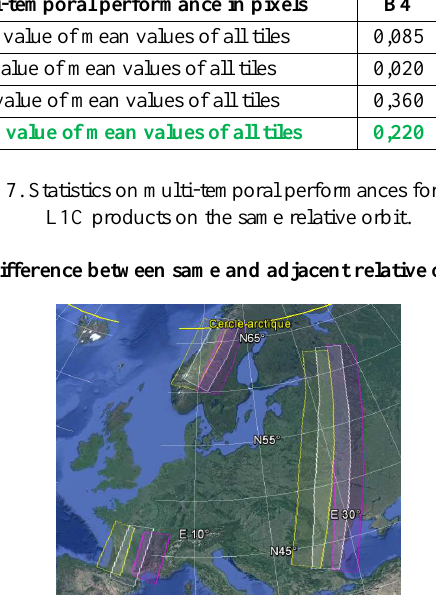
Figure 20. Footprints of products analyzed for multi-temporal analysis on adjacent orbits.